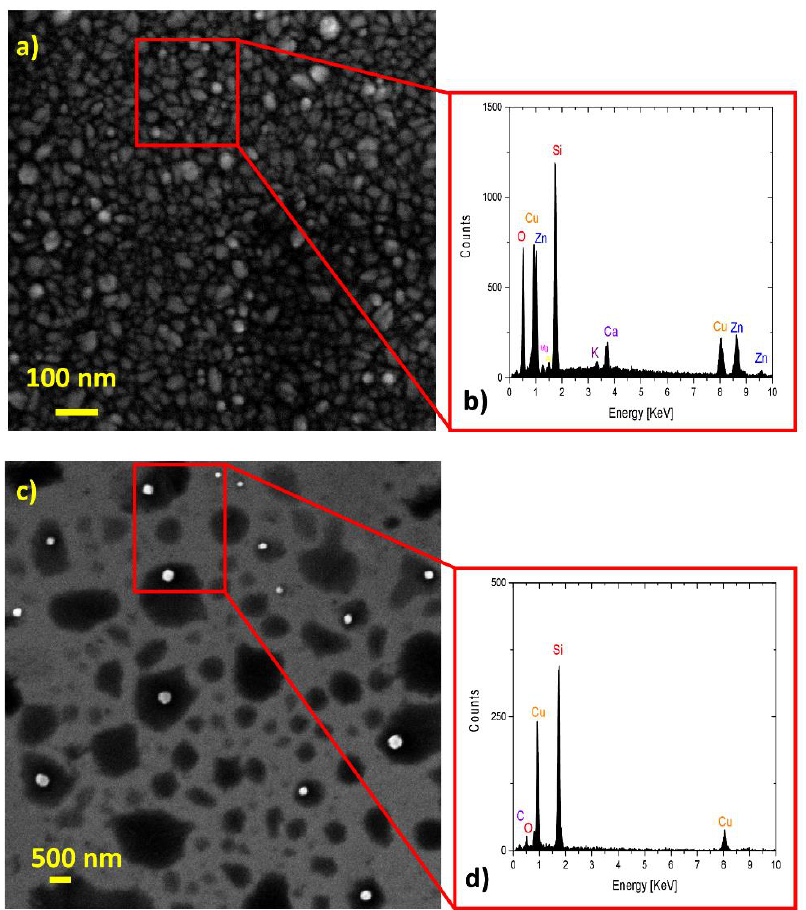
Figure 2. ( a ) SEM image of Cu nanoparticles produced in acetone on AZO bottom layer; ( b ) EDX spectrum of the sample shown in ( a ) acquired over the Cu nanostructures on the position indicated by the red square; ( c ) SEM image of Cu nanoparticles produced in methanol deposited on Si layer; ( d ) EDX spectrum of the sample shown in ( c ) acquired over the Cu nanostructures on the position indicated by the red square.